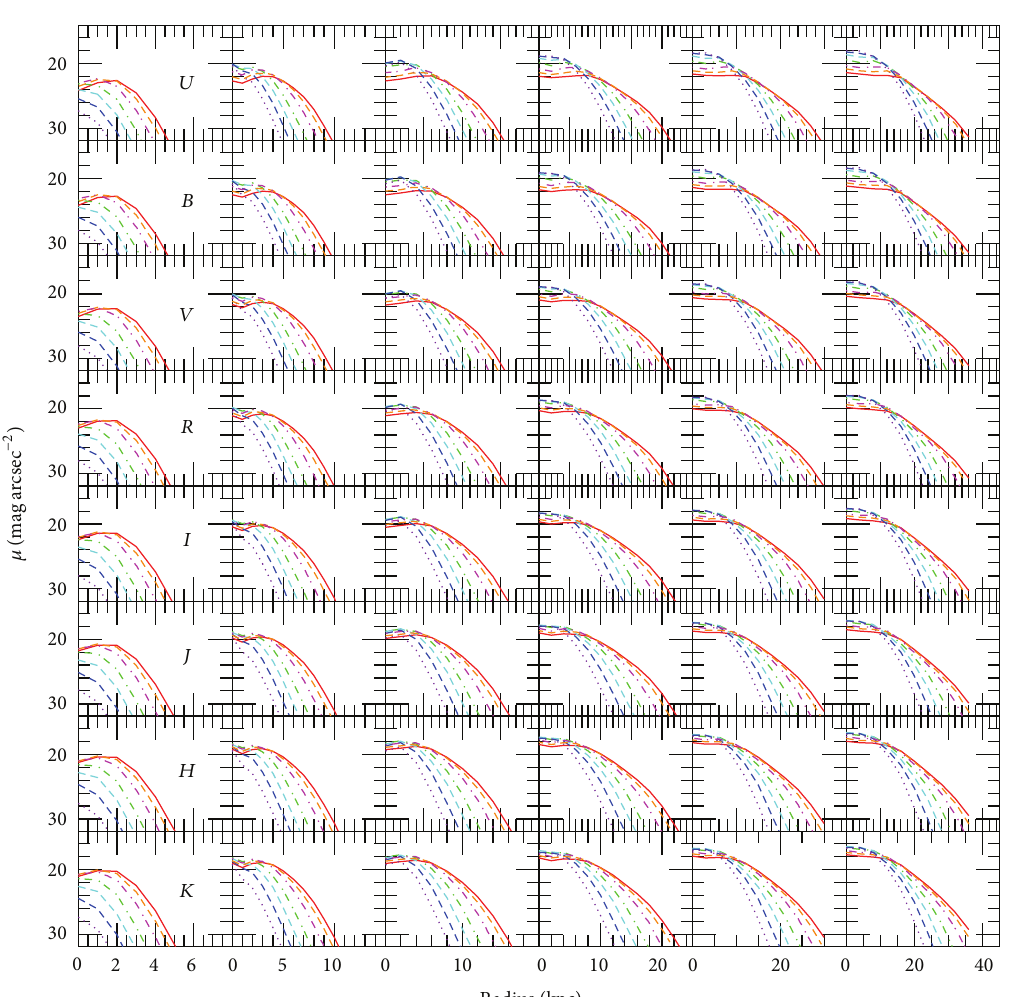
Figure 12: Evolution with redshift of surface brightness profiles in 𝑈 , 𝐵 , 𝑉 , 𝑅 , 𝐼 , 𝐽 , 𝐻 , and 𝐾 bands. Each row shows the results for a theoretical galaxy of the Table 1, from the galaxy, with 𝑉 max = 78 kms −1 , to the most massive on the bottom for 𝑉 max = 290 kms −1 . Lines purple, blue, cyan, green, magenta, orange, and red are for 𝑧 = 5, 4, 3, 2, 1, 0.4, and 0,